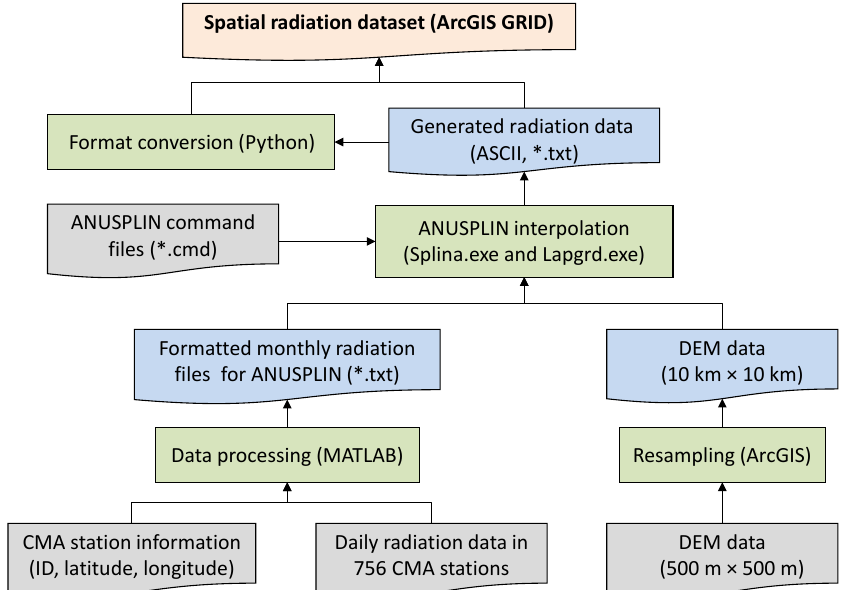
Figure 4. The workflow of the generation of radiation